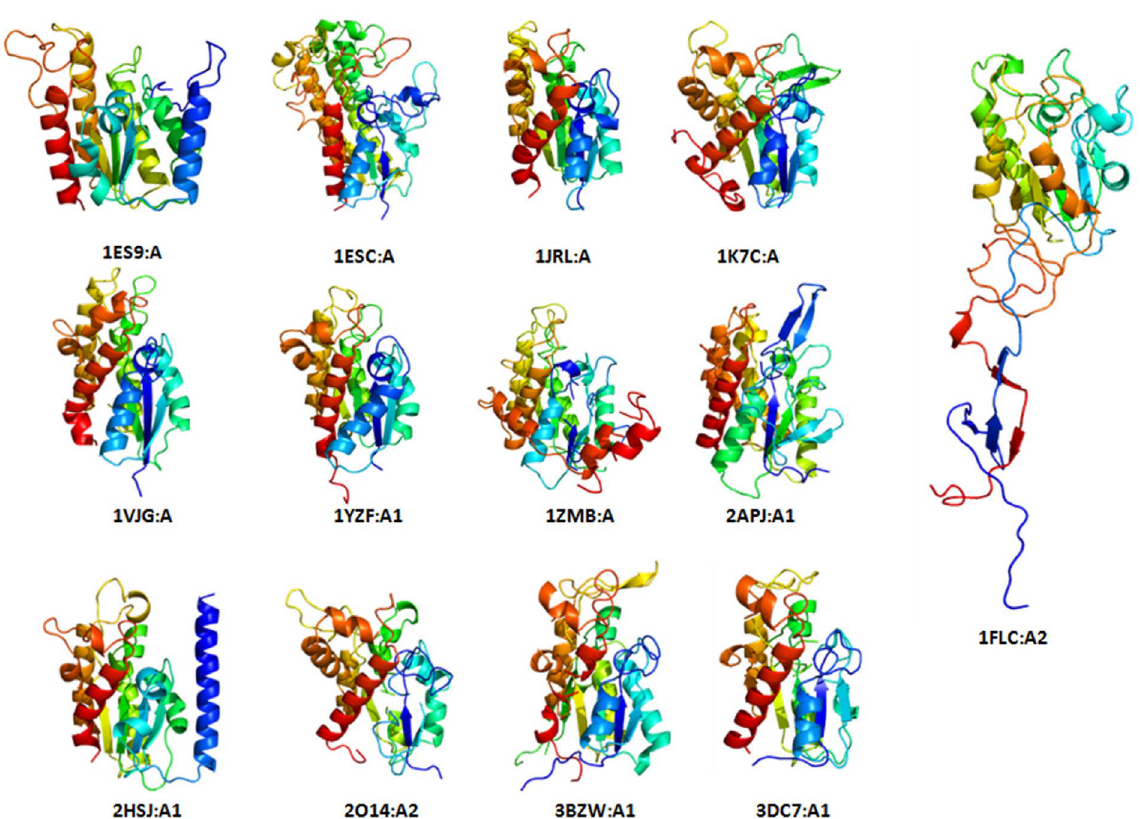
Figure 9. Structural view of all the distantly related domains of SGNH hydrolase superfamily. Conformations of N- and C-terminal part are conserved in all domains except 1FLC:A2. This domain has extra elongated N and C-terminal part which is involved in fusion. doi:10.1371/journal.pone.0074416.g009 (Figure 8). The superfamily Polo-box domain consists of b (6)- a motif arrangement, where all the six b sheets are anti-parallel.